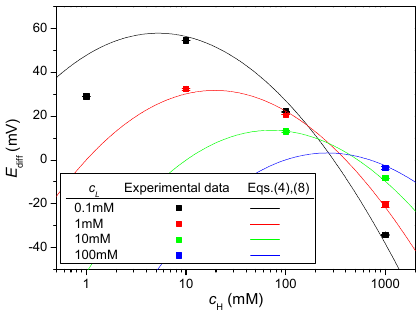
Figure 8. Open circuit voltage for various concentrations of both NaCl solutions.